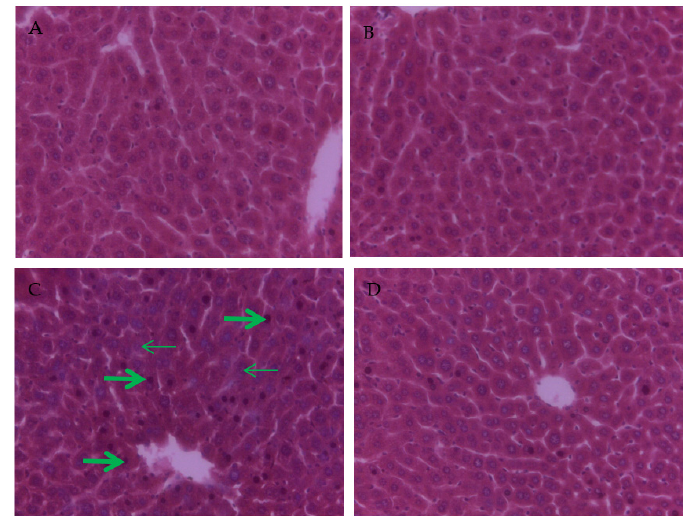
Figure 1. The effects of PCs on lead ‐ induced liver histopathological changes in mice (original magnification of 400×). ( A ) Control group; ( B ) PCs group; ( C ) group administrated with lead; and ( D ) group co ‐ treated with lead and PCs at a dose of 100 mg/kg. Thick arrow: nuclei pyknosis; Thin arrow: dissolved nuclei.